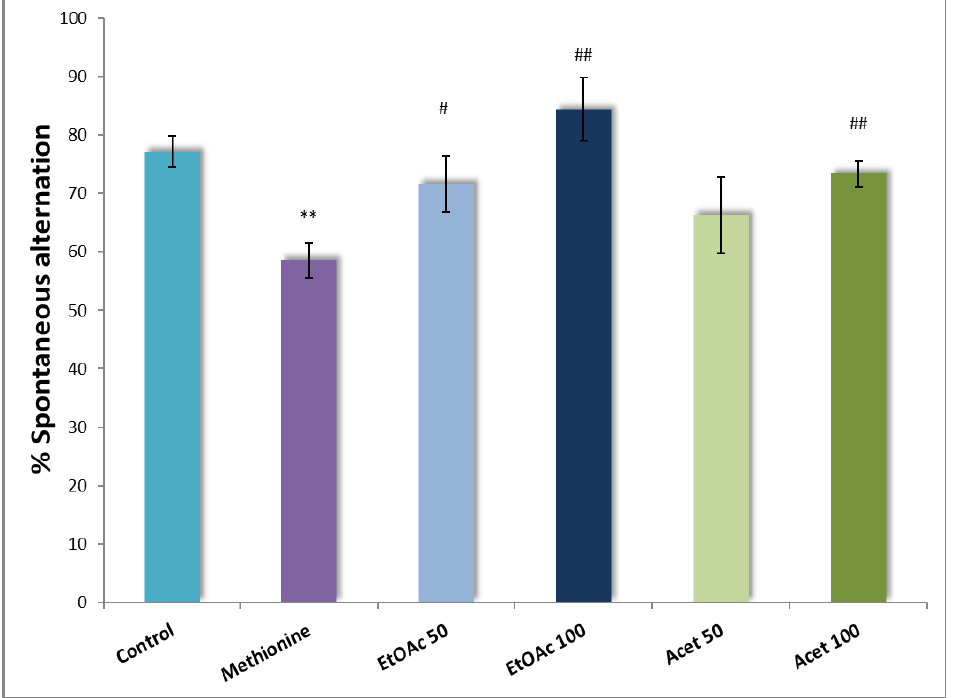
Figure 2. Carob seed peels extract effect) on spontaneous alternation percentage in Y-maze task vs. Control and methionine groups. Data represent the mean ± SEM ( n = 4 – 6 per group) with ** p ≤ 0.01 vs. Control group, # p ≤ 0.05 and ## p ≤ 0.01 vs. methionine group.